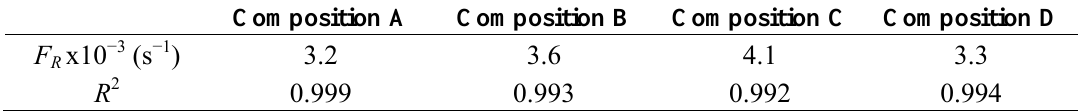
Table 3. Polymerization rates ( F each chemical composition.